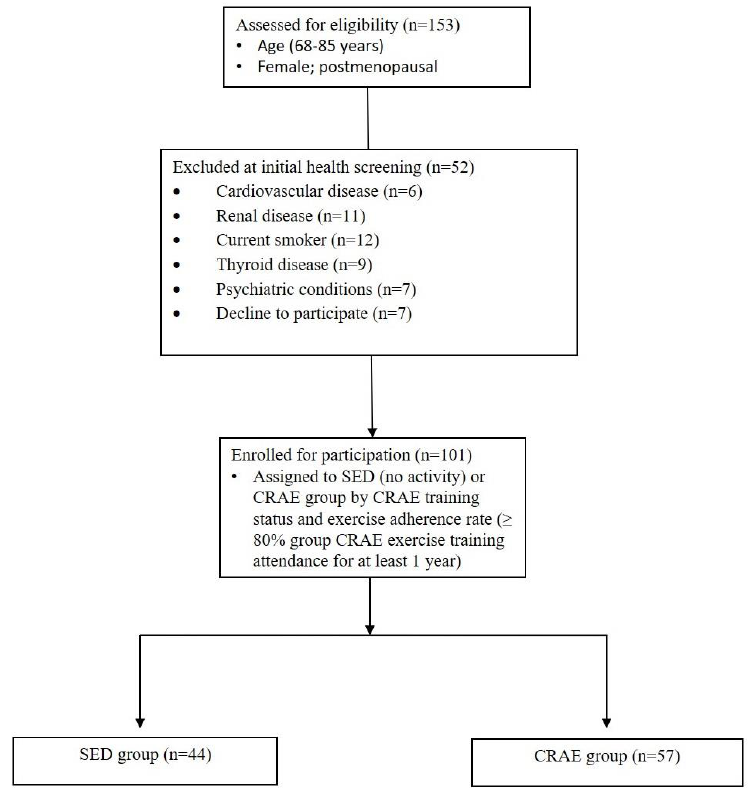
Figure 1. Study subject eligibility, screening, and allocation.